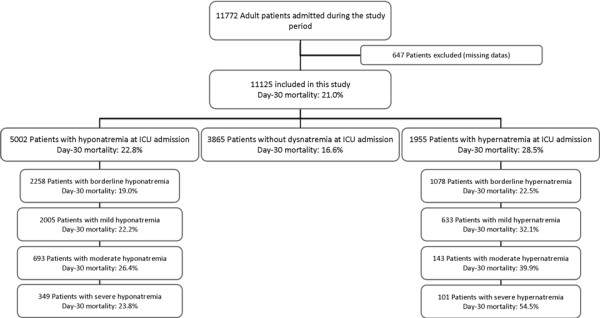
Flow chart of patients admitted during the study period.